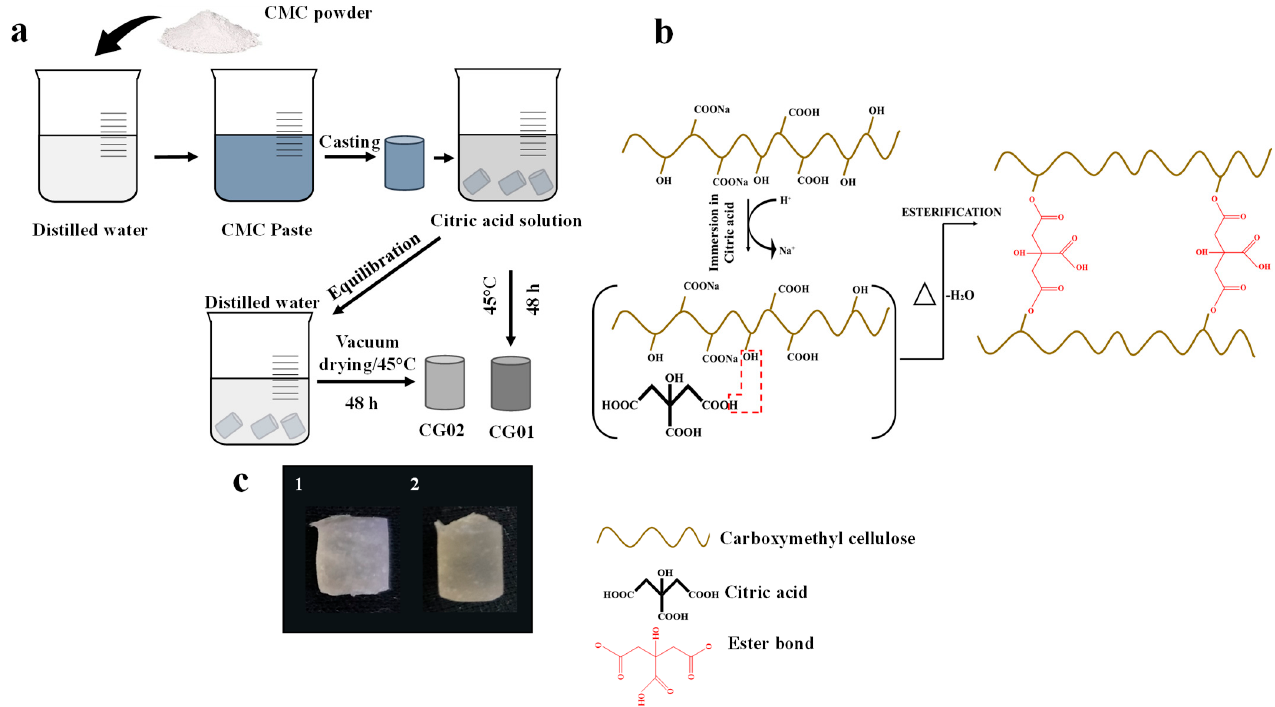
Figure 1. ( a ) Graphical illustration describes the method of preparation of CG01 and CG02 hydro- gels, ( b ) crosslinking mechanism of hydrogels, and ( c ) photographic images of fabricated hydrogels CG01 ( c1 ) and CG02 ( c2 ).